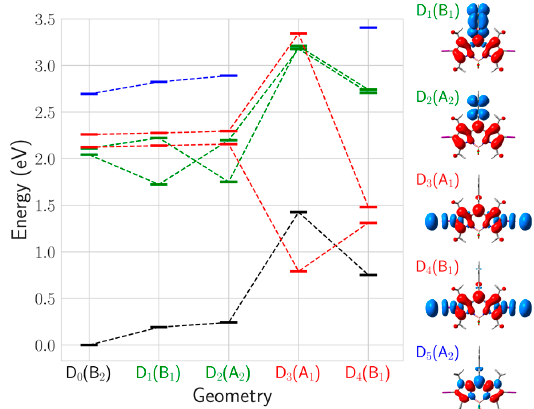
Figure 3. TDDFT geometry-states correlation diagram for the first five doublet states and charge density differences. Color code: doublet ground state (black), bright excited doublet state (blue), dissociative doublet state (red), and CT doublet state (green). Since D 3 (A 1 ) becomes the electronic ground state within its equilibrium, the bright D 5 state cannot be described in this structure using a single determinate method, i.e., TDDFT.